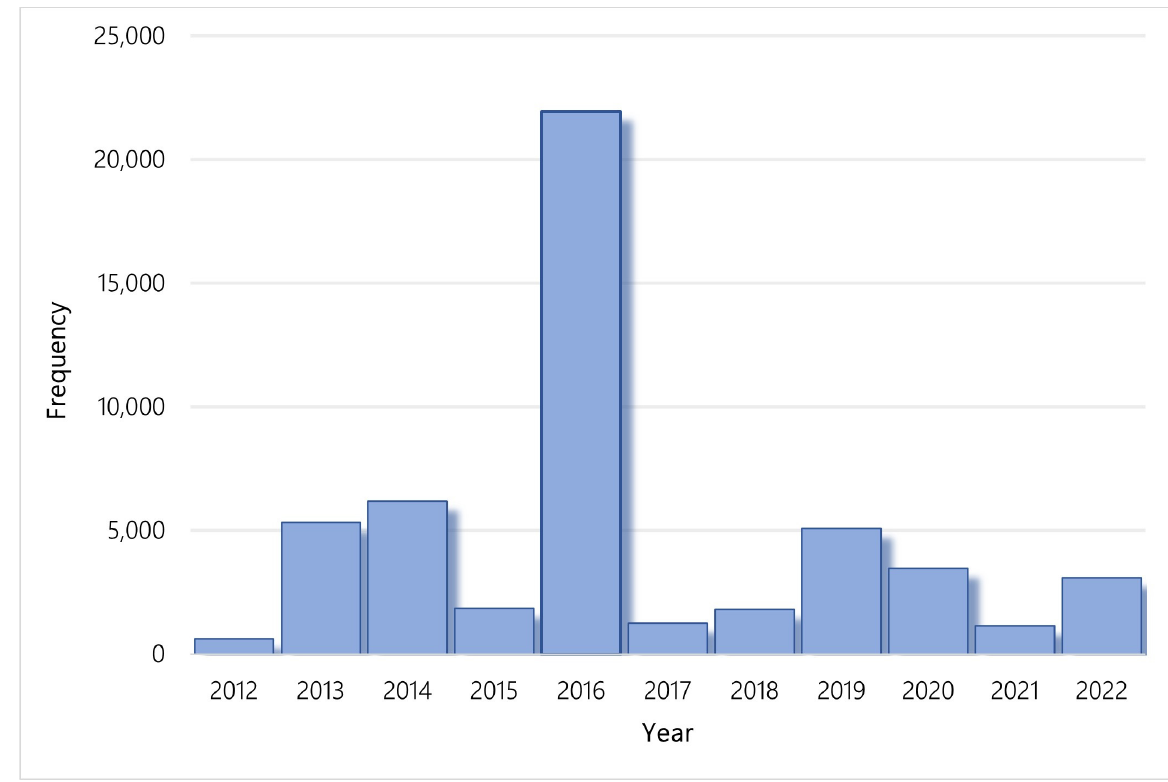
Figure 3. Number of new genetic tests per year, US.